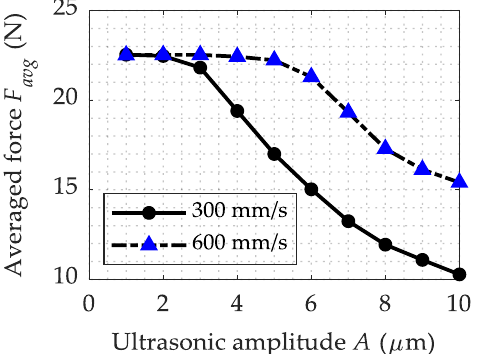
Figure 6. FEM calculation results of average ultrasonic drawing force with different ultrasonic amplitudes at drawing speed of 300 mm/s and 600 mm/s.